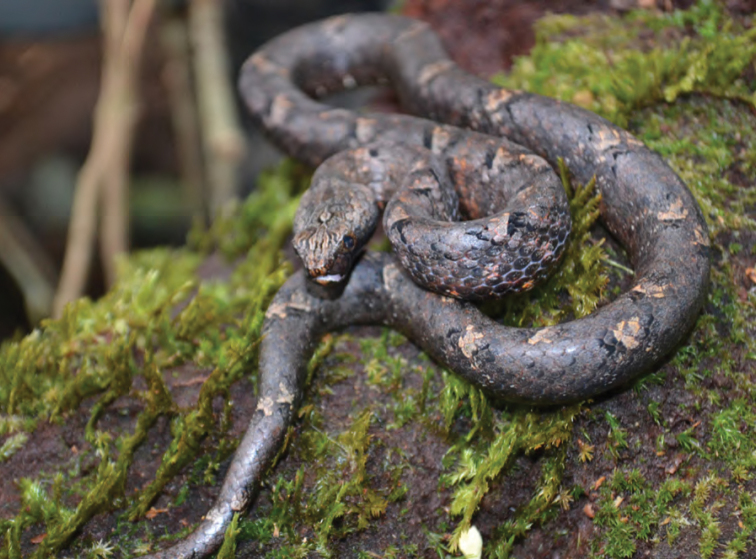
Psammodynastes pulverulentus from Location 1a (KU 330023). Photo: JS.